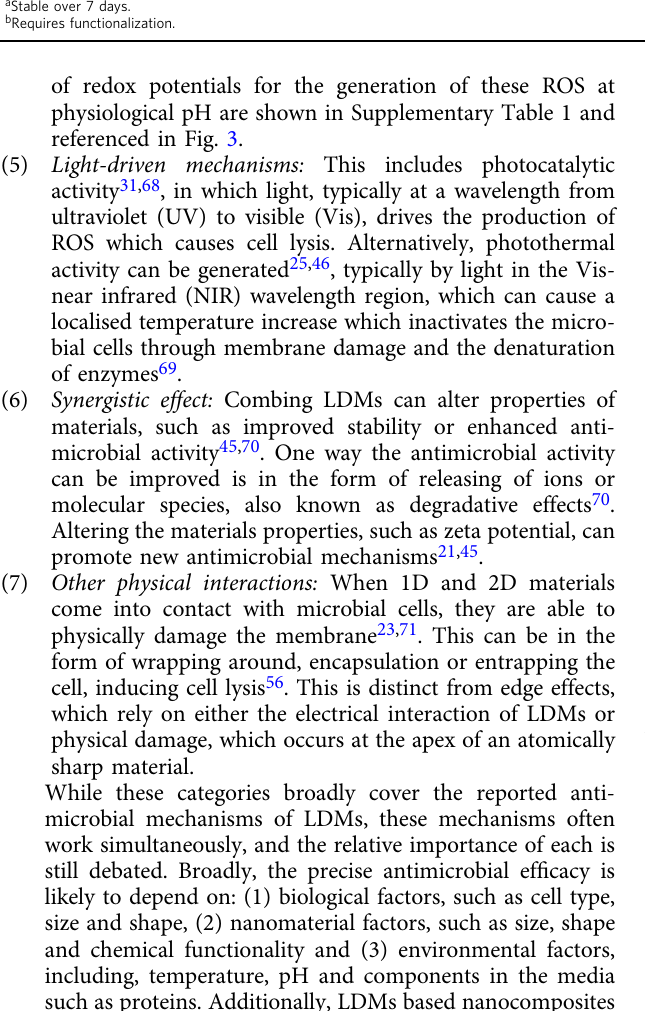
a Stable over 7 days. b Requires